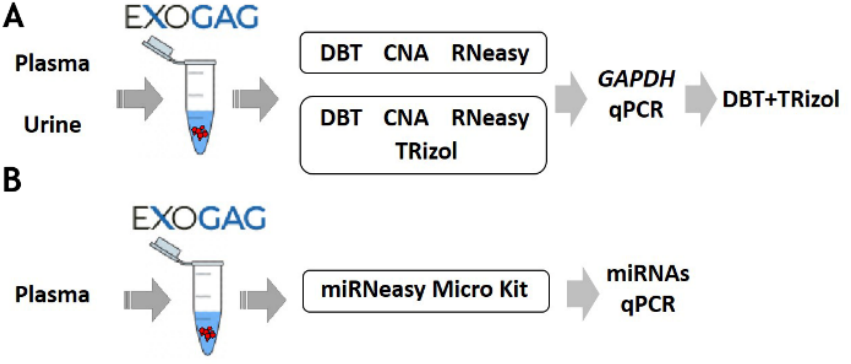
Figure 4. Schematic of the protocol for optimization of ( A ) RNA and ( B ) miRNA purification methodologies of EVs isolated with ExoGAG from plasma and urine.